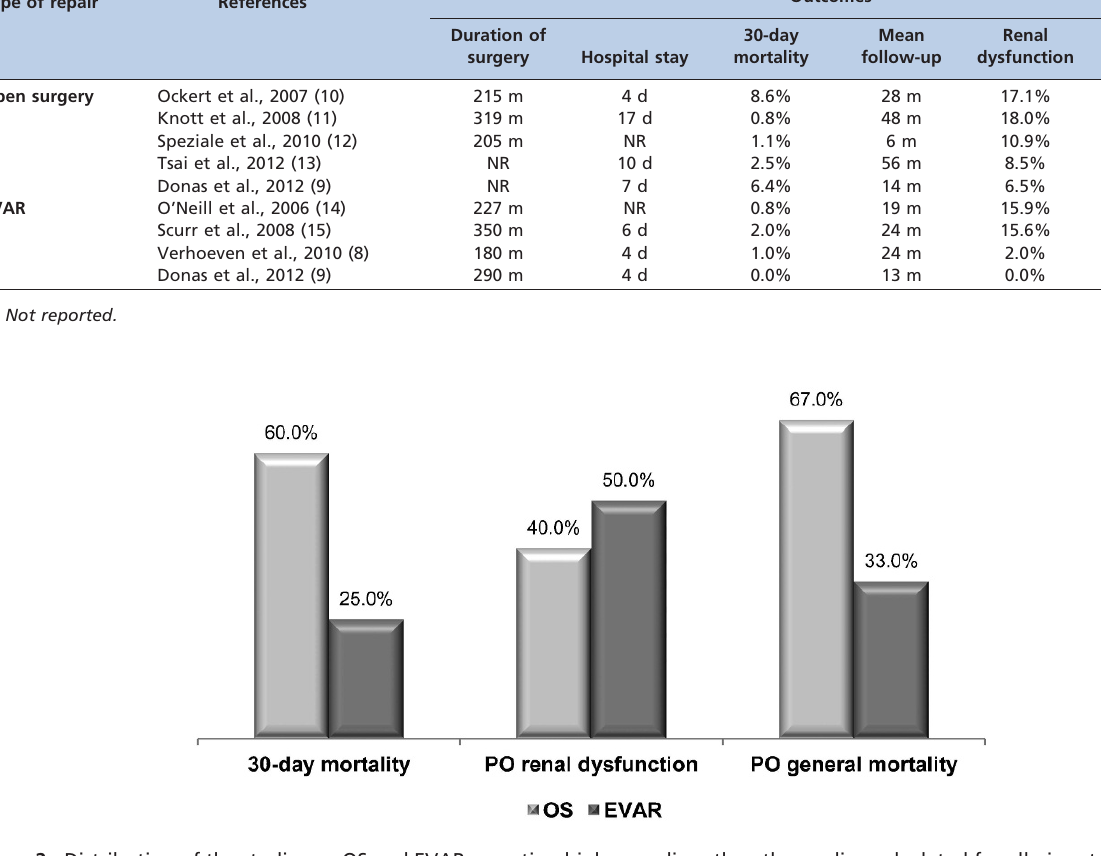
Figure 2 - Distribution of the studies on OS and EVAR reporting higher medians than the median calculated for all nine studies on the treatment of juxtarenal aortic abdominal aneurysms.